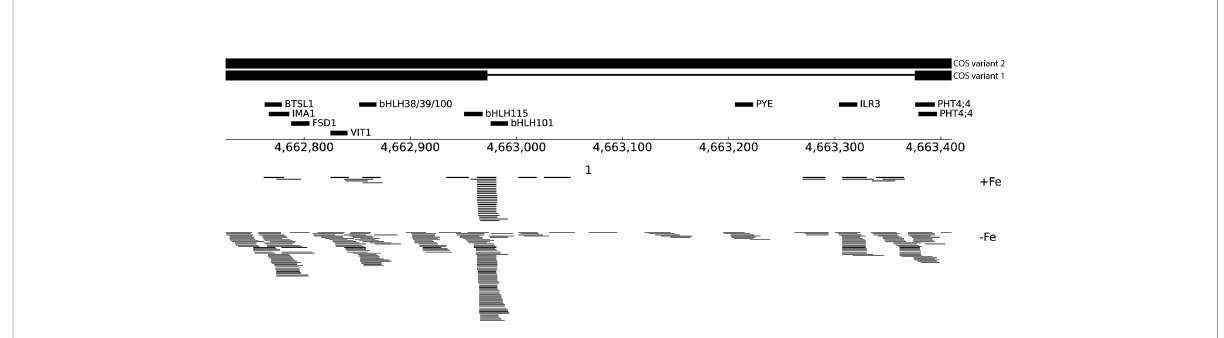
FIGURE 6 Small RNA reads at the COS locus. Schematic representation of an ~600 bp region within COS that shares sequence complementarity to several Fe-de fi ciency genes, indicated with thick black lines labeled with putative target genes. At bottom, sRNAseq reads mapping to COS are shown from both +Fe and -Fe